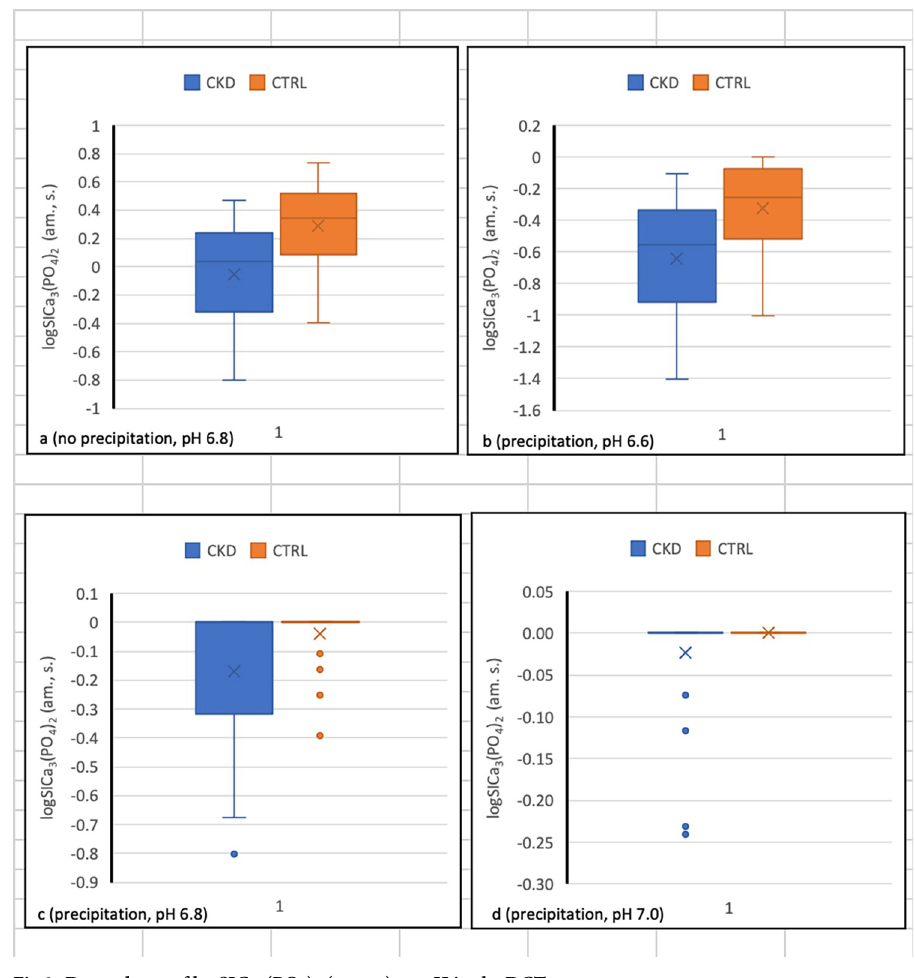
Fig 2. Dependence of logSICa 3 (PO 4 ) 2 (am., s.) on pH in the